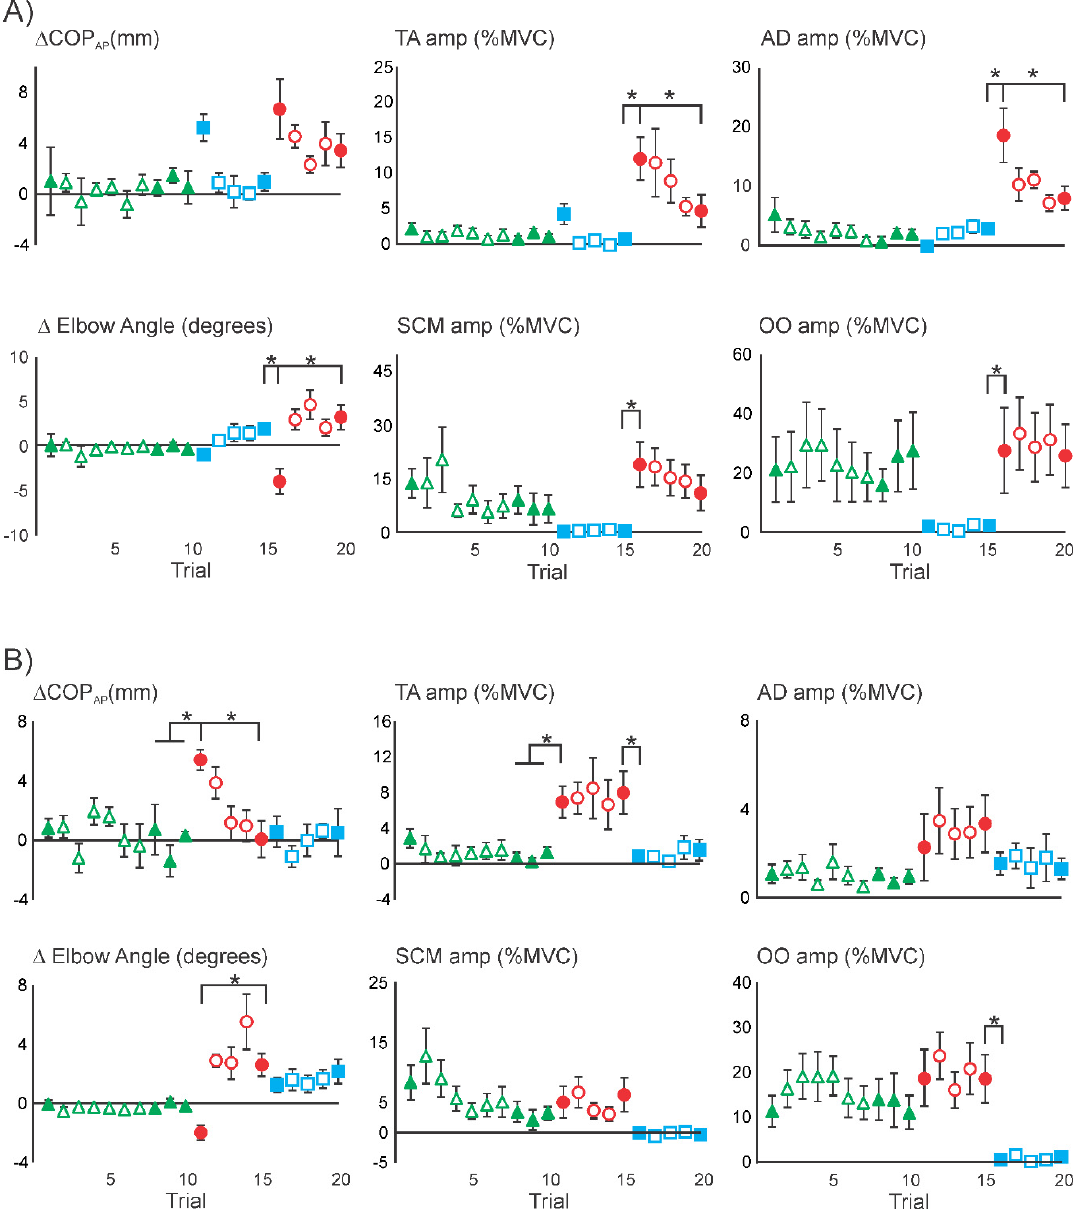
Figure 8. Trial-by-trial mean (SE) mechanical and muscle response amplitudes for participants who habituated to the STARTLE stimuli initially. ( A ) Participants subsequently received the DISPLACEMENT, followed by the COMBINED stimuli. ( B ) Participants subsequently received the COMBINED stimuli, followed by the DISPLACEMENT. Asterisks indicate differences identified by Tukey’s HSD comparisons ( p < 0.05). Blue squares, DISPLACEMENT; Red circles, COMBINED; Green triangles, STARTLE. Closed symbols indicate data points used in the statistical analysis. TA, tibialis anterior; AD, anterior deltoid; SCM, sternocleidomastoid; OO, orbicularis oculi; COP AP , center of pressure anterior–posterior; MVC, maximum voluntary contraction.